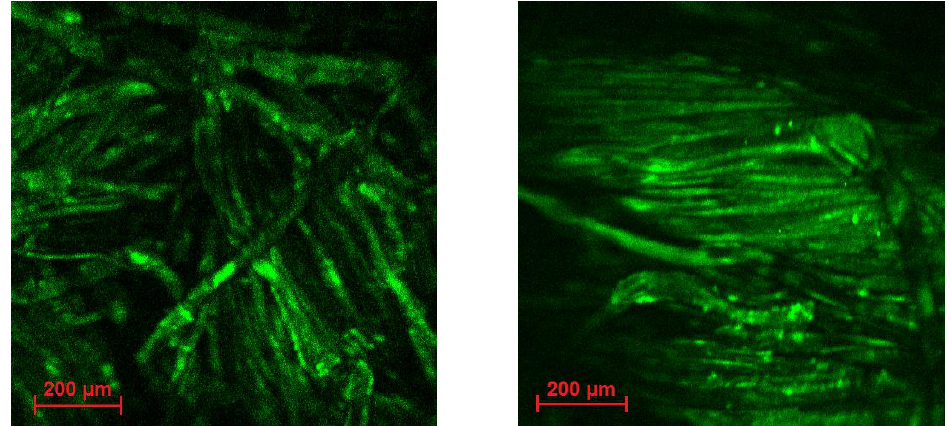
Figure 6. 2p-fluorescen image of textiles coated by blue Ir@SiO 2 system ( left ) and red Ir@SiO 2 system ( right ).